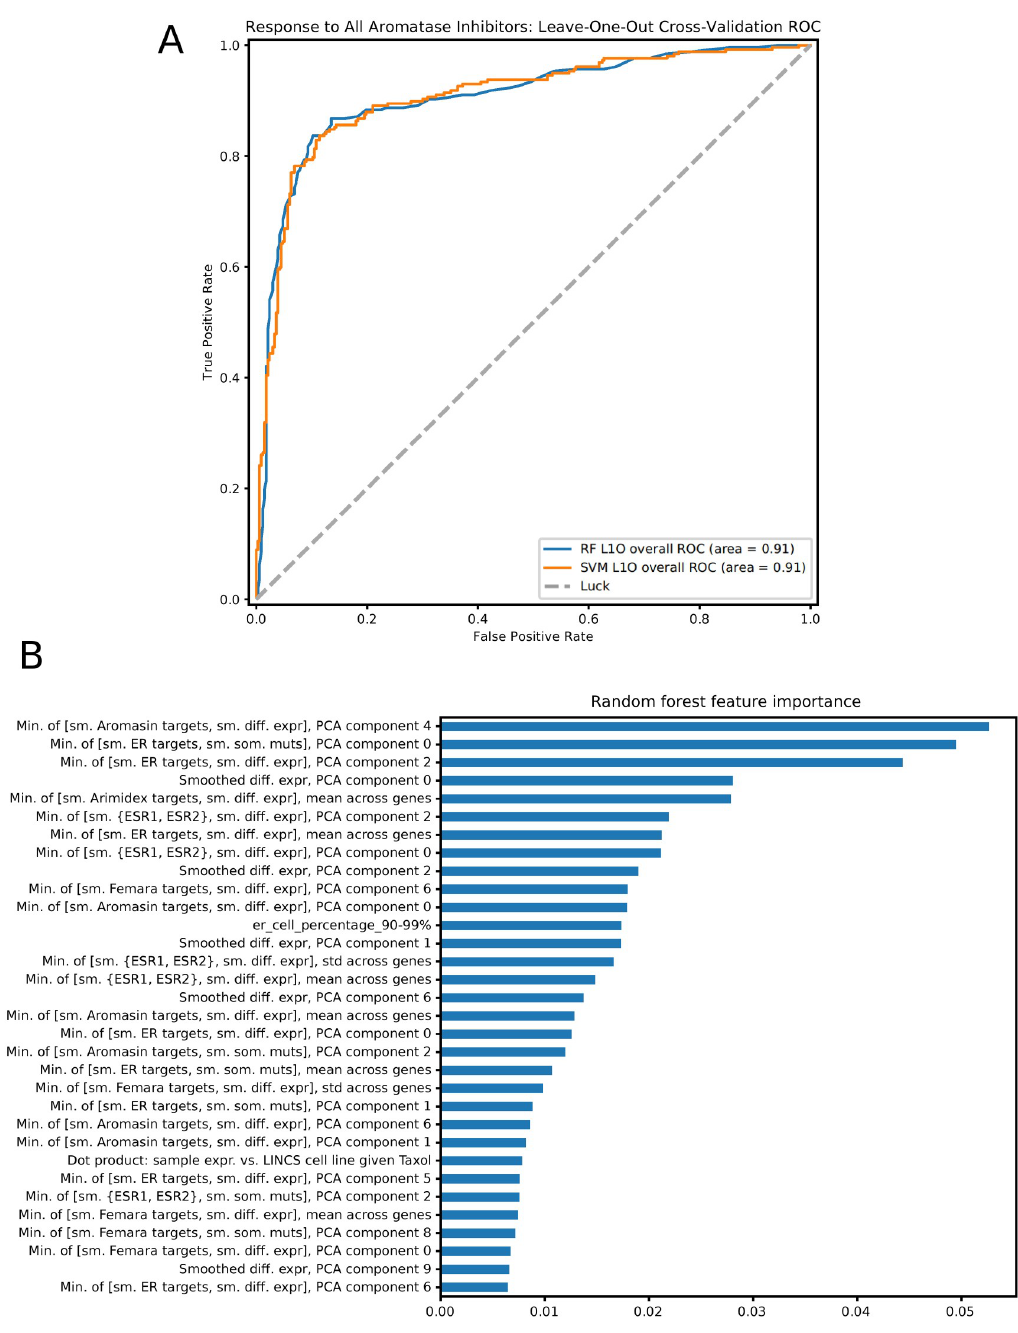
Fig 2. (a) Leave-one-out cross-validation results for prediction of non-response to all aromatase inhibitors, using random forests and probabilistic support vector machines. (b) Feature importance from the random forest cross-validation results, showing which constructed features contribute most to the random forest fit. Features prefixed with “Min.” denote elementwise minimum of pairs of matrices, e.g. smoothed (“sm.”) drug targets of Arimidex and smoothed binary differential expression as shown in the first feature listed. “sm. {ESR1, ESR2}” denotes network proximity to the ESR1 and ESR2 genes. Sample × gene matrices are collapsed across genes in various ways to produce feature values for samples: mean or standard deviation across all genes, or through PCA decomposition. Categorical clinical features are represented with one-hot encoding, and are shown as “feature name_column name”, e.g. “er_cell_percentage_90-99%”.